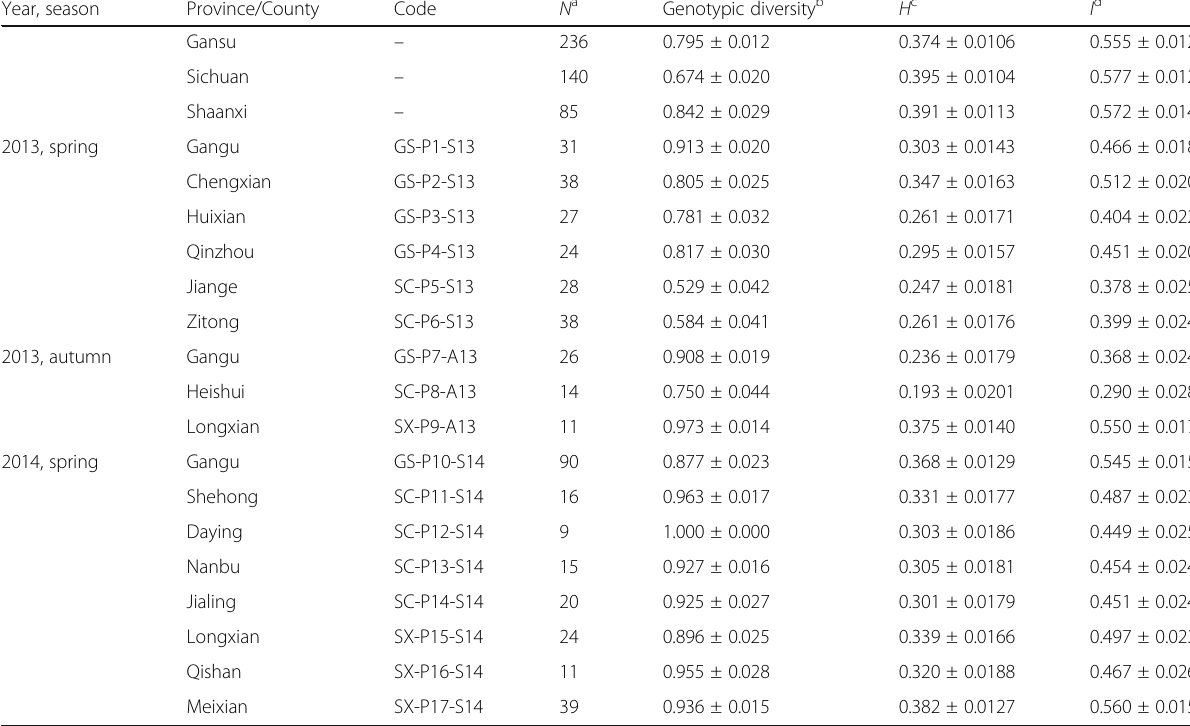
Table 1 Genotypic and genetic diversities of subpopulations of Puccinia striiformis f. sp. tritici